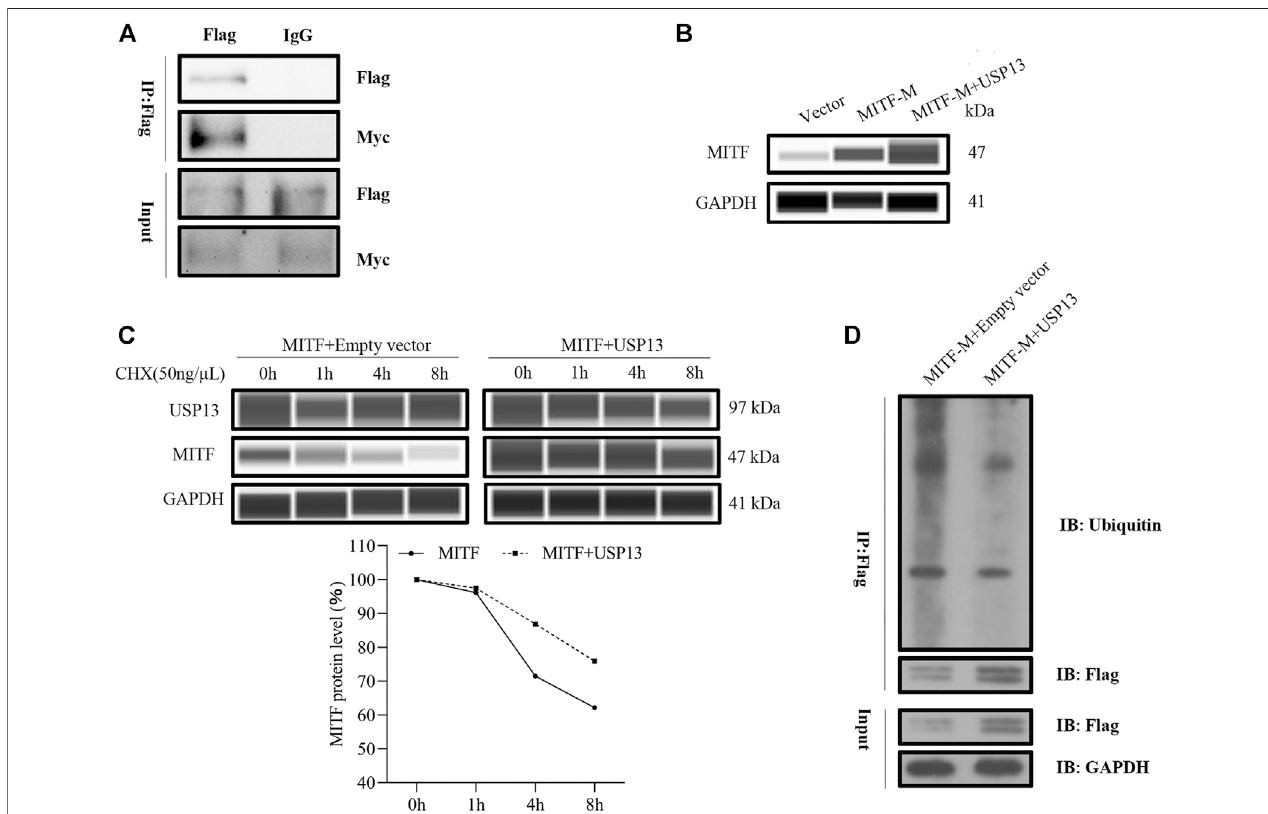
FIGURE5| ExogenousUSP13interactedwithMITF-MandstabilizedtheexogenousMITFproteinlevels. (A) Melanocytesco-transfectedwithFlag-taggedUSP13 and Myc-tagged MITF-M were immunoprecipitated using anti-Flag antibody and the protein complex was detected through western blot analysis using anti-Myc and anti-Flag antibodies. (B) MITF-M protein was detected in MITF-M overexpressing group, and pcDNA3.1-Myc-USP13 and pcDNA3.1-Flag-MITF-M co-transfected melanocytesusingWes. (C) MelanocytesweretransfectedwithMITF-M,USP13,orplainvectorandincubatedfor3 days.Later,thetransfected cellsweretreated with 50 ng/ μ l CHX for 1, 4, and 8 h. Cells were collected at the indicated time points, and MITF, USP13, and GAPDH protein levels were measured by Wes using MITF, USP13, and GAPDH antibodies. The MITF protein bands were quanti fi ed by calculating the area of Wes and normalized using GAPDH. (D) MITF-M ubiquitination level wasdeterminedafterpcDNA3.1-Flag-MITF-MandpcDNA3.1-Myc-USP13wereco-transfectedinmelanocytes.Theanti-Flagantibodywasusedtoimmunoprecipitate, the anti-GAPDH mouse monoclonal antibody and anti-Flag antibody were used in western blot